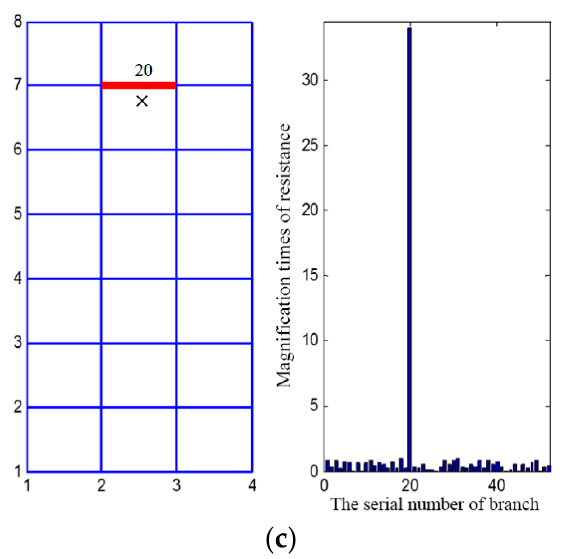
Figure 10. The results of the single branch fault case with a real resistance network. ( a ) The resistance of the fault branch was 5 Ω ; ( b ) The resistance of the fault branch was 10 Ω ; ( c ) The fault branch was broken.